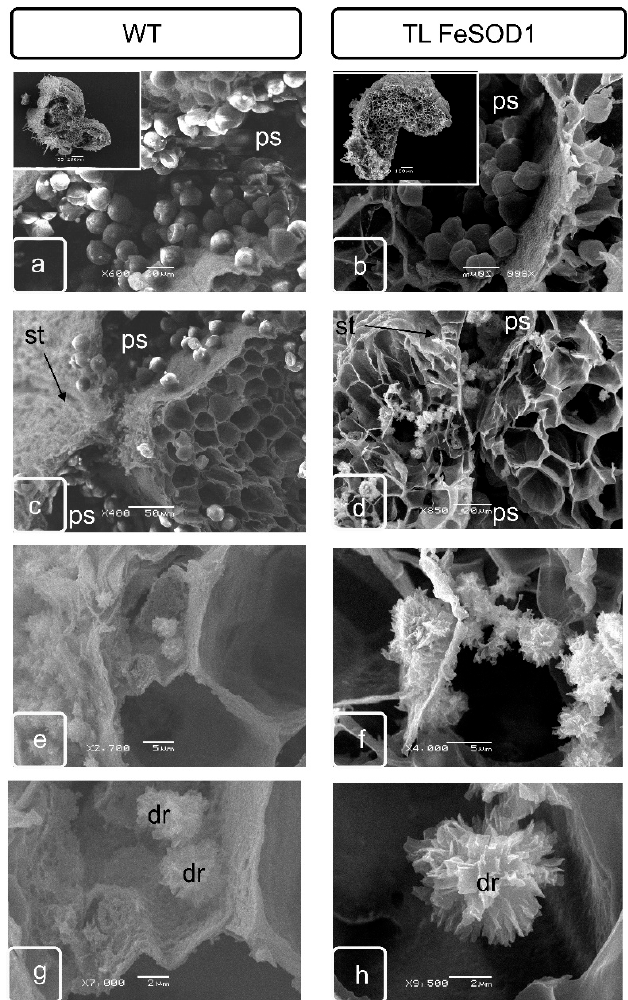
Figure 2. Scanning electron microscopy of pollen sac cells and stomium zone from WT ( a , c , e , g ) and transgenic ( b , d , f , h ) tomato plants. Ps—pollen sac; st—stomium; dr—druse.